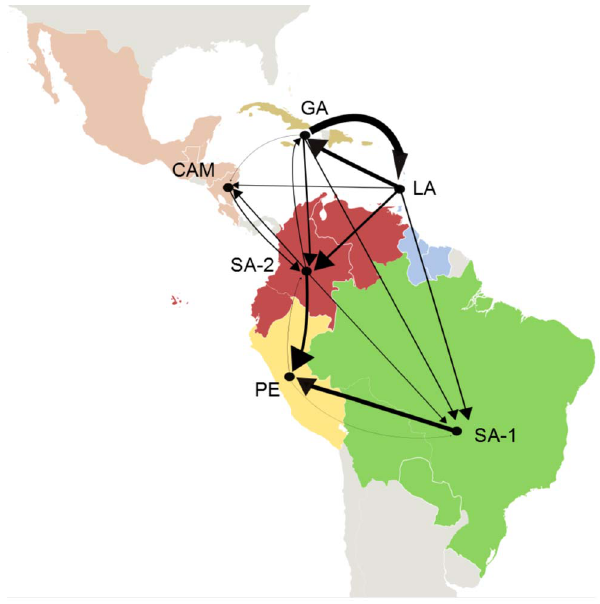
Figure 3. Major estimated viral migration rates among locations as measured using ‘Markov jump’ counts. The width of the arrows is proportional to the viral transitions rate. Transition rates lower than 0.1 were excluded for clarity. (CAM: Central America-Mexico, GA: Greater Antilles, LA: Lesser Antilles, PE: Peru, SA-1: South America 1, SA-2: South America